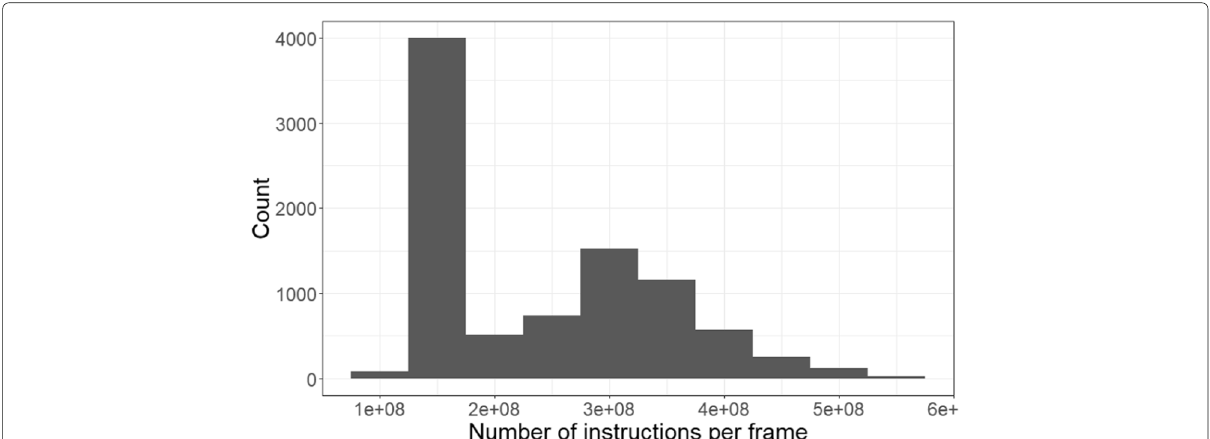
Fig. 7 Measured number of instructions per frame for the reference